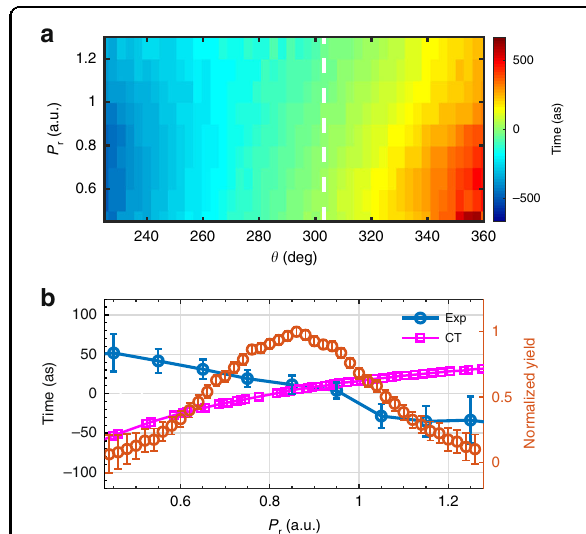
Fig. 4 Energy- and angle-resolved tunneling ionization time. a The extracted tunneling ionization time with respect to the electron momentum p r and the electron emission angle from the measurement. b The lineout taken at the emission angle of 303° from ( a ). The prediction by the classical-trajectory (CT) model is shown by the squares. For comparison, the normalized yield as a function of the electron momentum at θ = 303° is shown by the red circles. The error bars for the ionization time show the 95% con fi dence interval for the fi tting process, and those for the photoelectron yield show the standard deviation of the statistical